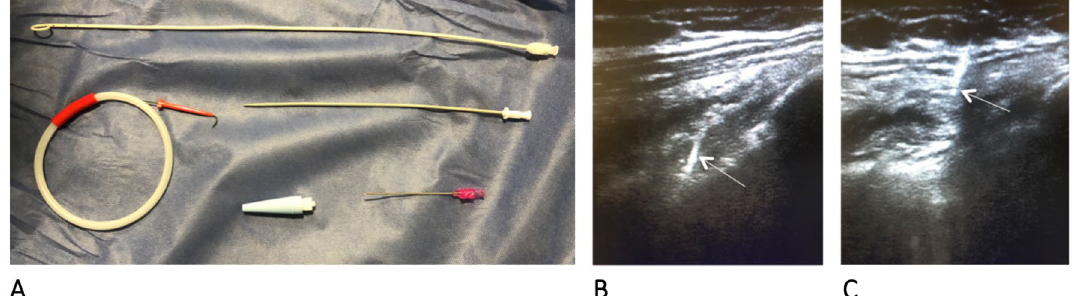
Fig. 2 A Thoracentesis kit B. Evaluation with a 13‑MHz linear transducer at the level of the fifth to seventh intercostal space along the mid‑axillary line, verifying the absence of pleural sliding at the puncture site; once vessel interposition is ruled out with color Doppler, the puncture is made; the passage of the needle to the pleural space is visualized in real time; visualization is lost upon entry into the pleural space given the presence of air (arrow) C. A guide wire is passed, verifying entry into the pleural space (arrow); as with the needle, visualization is lost when entering the